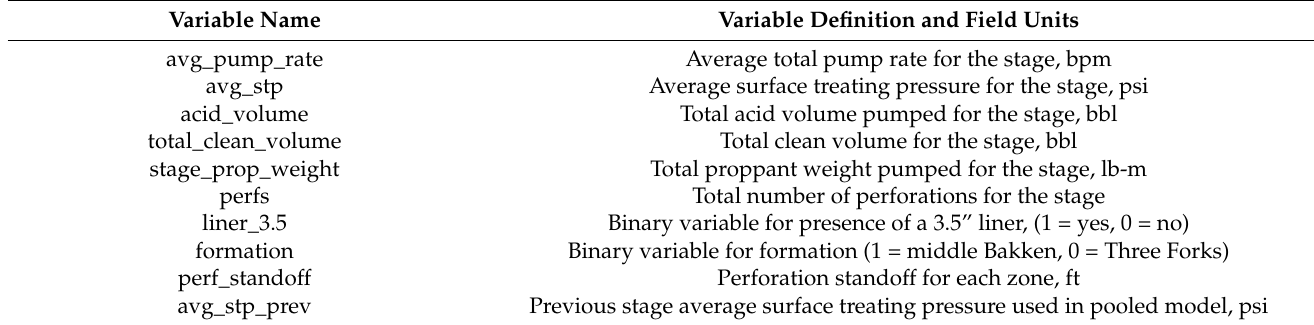
Figure 3. Cross ‐ sectional data set from re ‐ fractured wells with associated trendlines highlighting Figure 3. Cross-sectional data set from re-fractured wells with associated trendlines highlighting the the effect of different within ‐ well characteristics. effect of different within-well characteristics. Table 2. Variable definitions